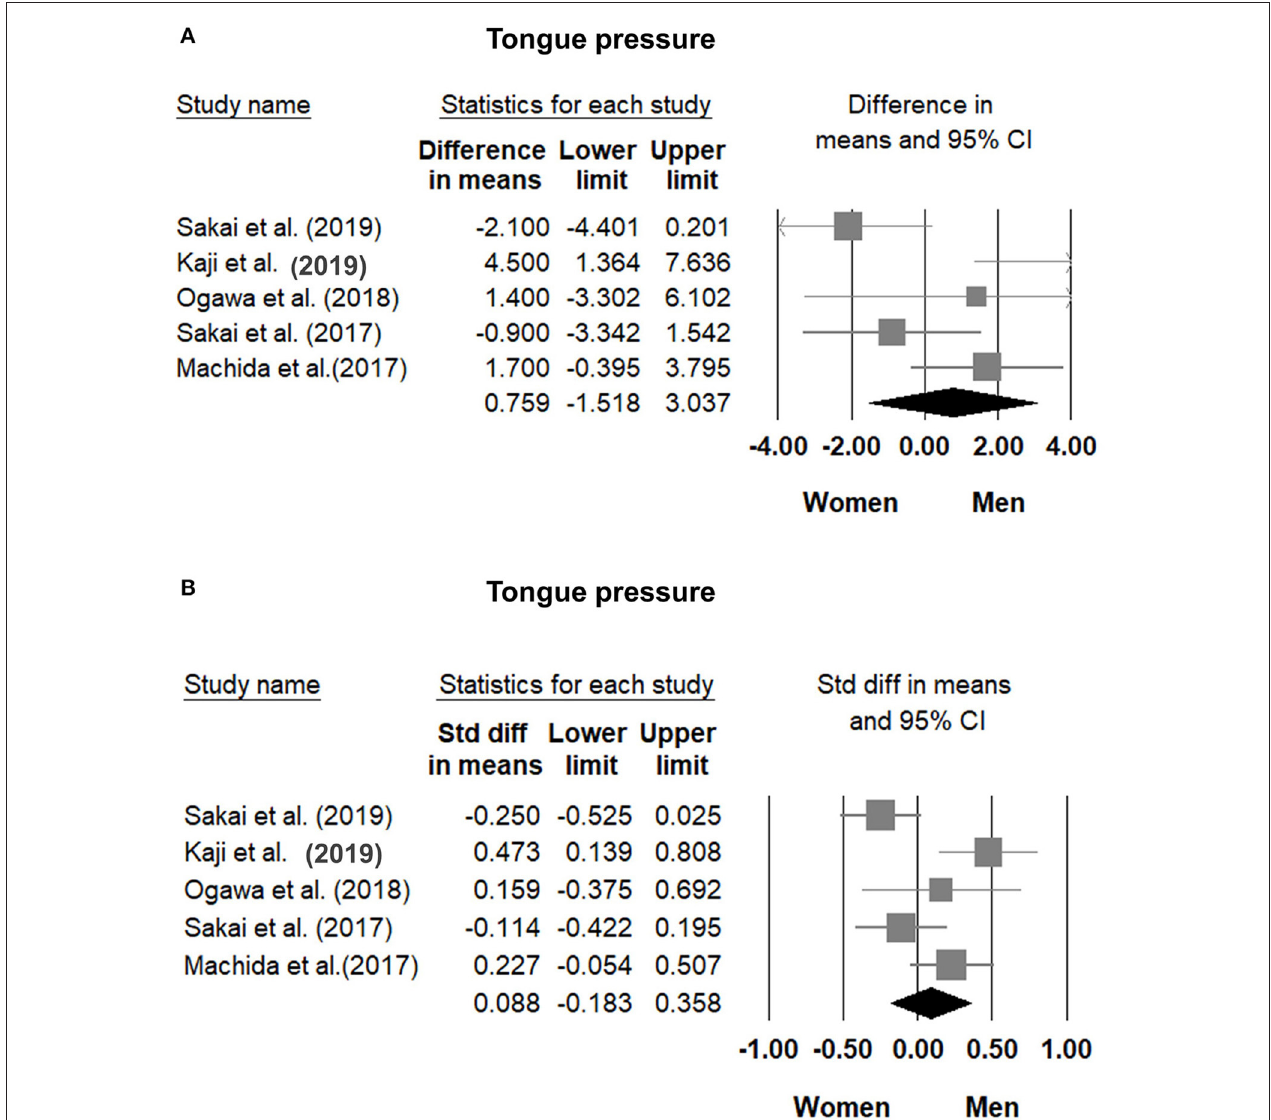
FIGURE 6 | Forest plot of the weighted mean difference (A) and standardized mean differences (B) of tongue pressure between men and women. Std diff, standardized